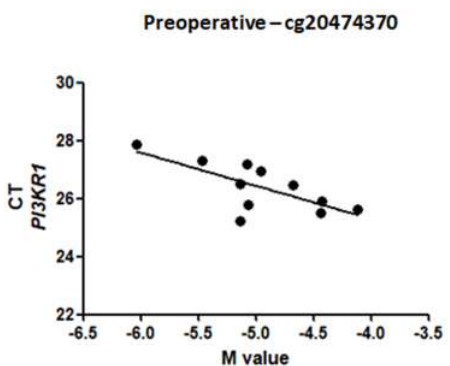
Figure 3. Correlation between gene expression data (RT-qPCR) and the M value in the site cg20474370 of PI3KR1 in before RYGB ( r = − 0.709, p < 0.01). CT: cycle threshold.